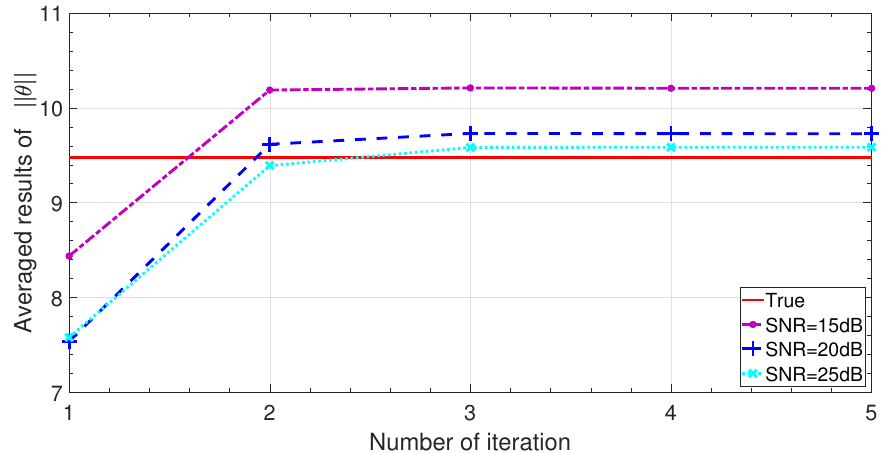
Figure 1. Averaged estimation results of (cid:107) θ (cid:107) 2 at each iteration for APM under different SNRs.